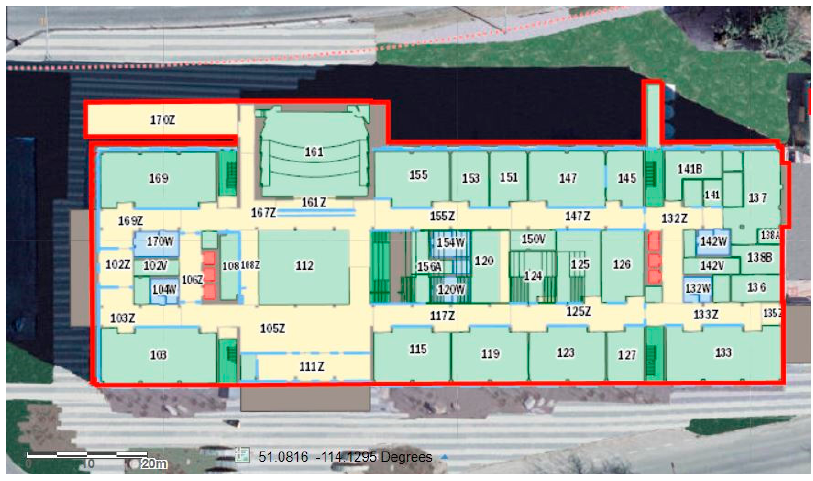
Figure 15. Outdoor map in front of the university library.